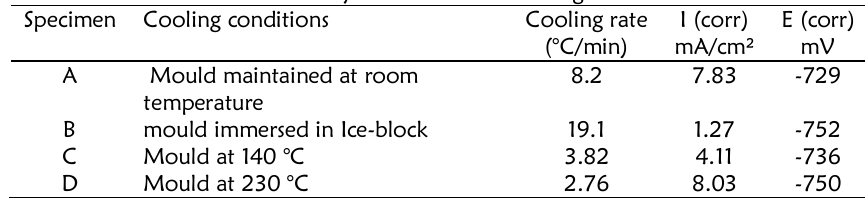
Table 4: Corrosion data of 6xxx aluminium alloy under different cooling